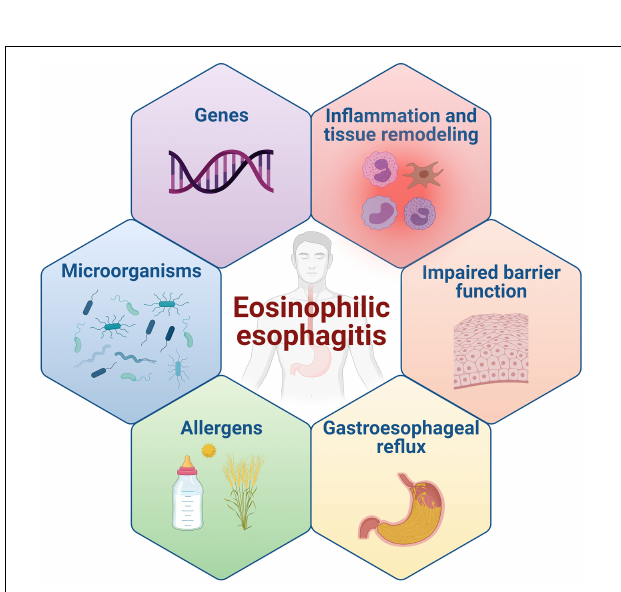
FIGURE 3 | Main pathogenetic mechanisms of EoE.